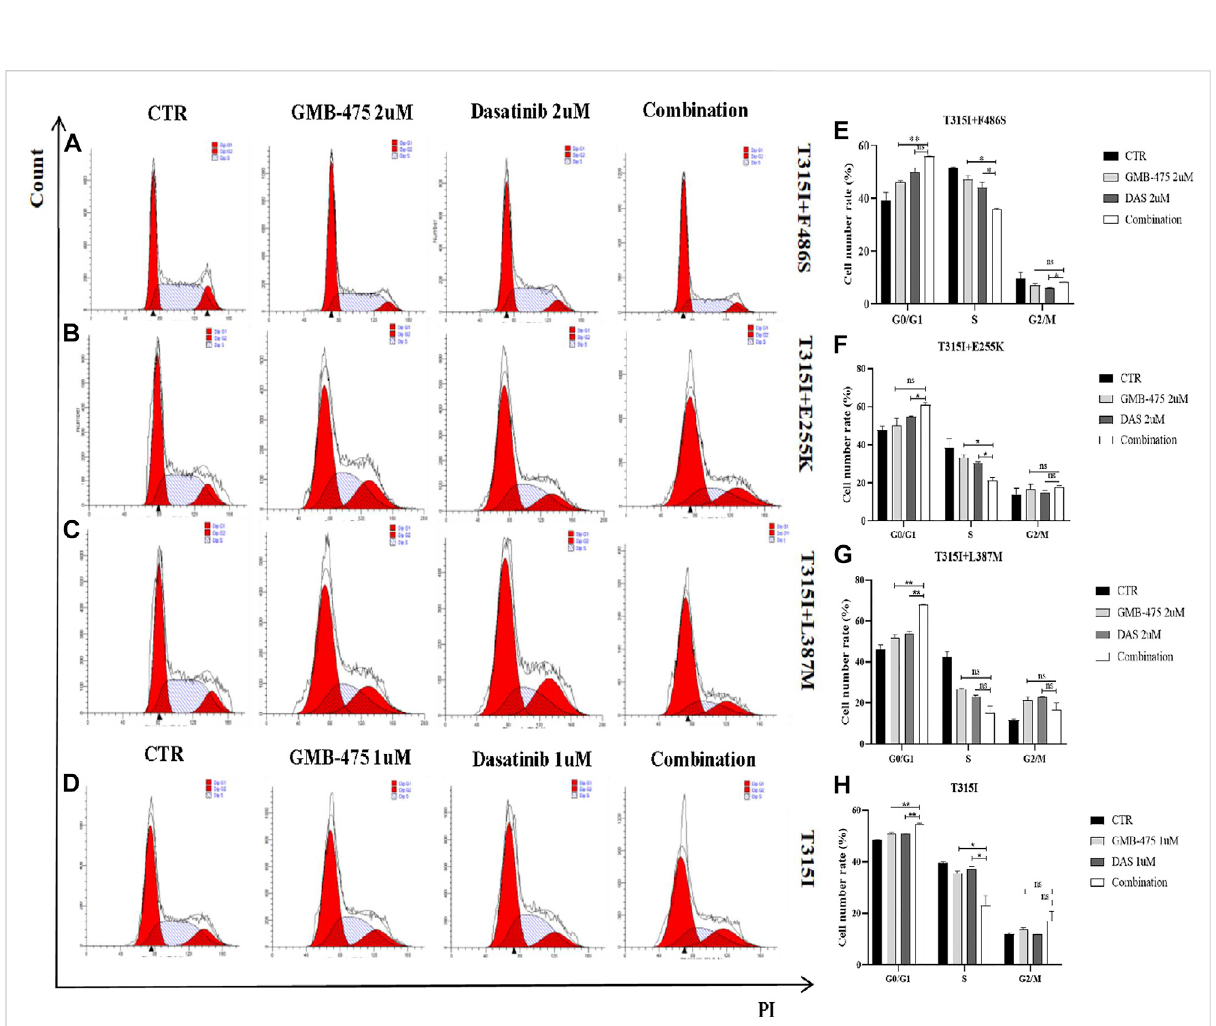
FIGURE 7 GMB-475combinedwithdasatinibsynergisticallyblockedthecellcycleofBa/F3-MIG-p210cellswithBCR::ABL1mutants.ThecellcycleofBa/ F3-MIG-p210 cells treated with the control medium (CTR), GMB-475, dasatinib (DAS), or GMB-475 plus dasatinib for 48 h was detected by PI staining: (A – C) Ba/F3-MIG-p210 cells carrying BCR::ABL1 T315I+F486S , BCR::ABL1 T315I+E255K , or BCR::ABL1 T315I+L387M compound mutations were treated with CTR, dasatinib 2 µM, GMB-475 2 µM, and GMB-475 2 µM plus dasatinib 2 µM, respectively. (D) Ba/F3-MIG-p210 cells carrying BCR:: ABL1 T315I were treated with CTR, dasatinib 1 µM, GMB-475 1 µM, and GMB-475 1 µM plus dasatinib 1 µM. (E – H) Statistical analysis results of the cell cycle. ns p ≥ 0.05, * p < 0.05, ** p <